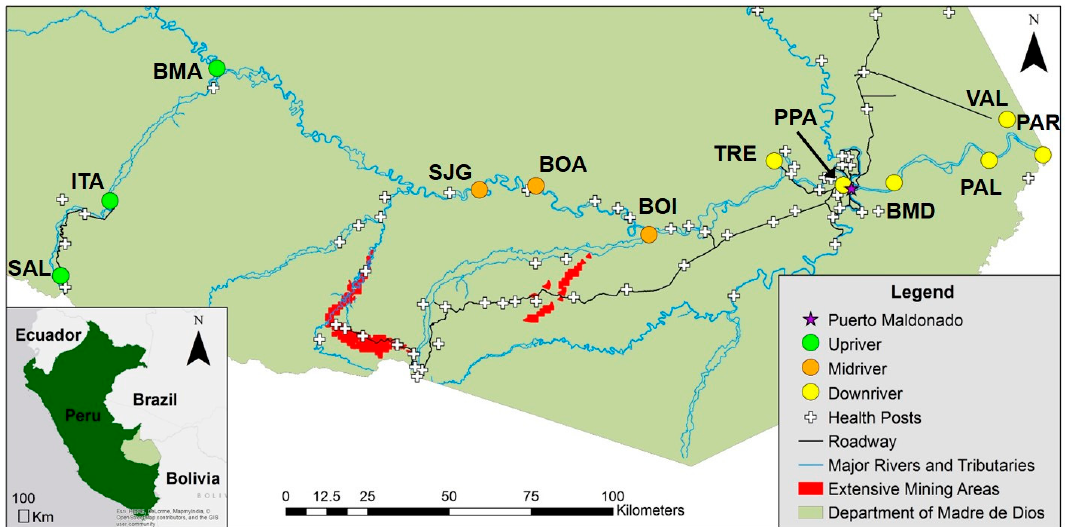
Figure 1. Map of selected study communities in Madre de Dios, Peru shown in reference to extensive mining